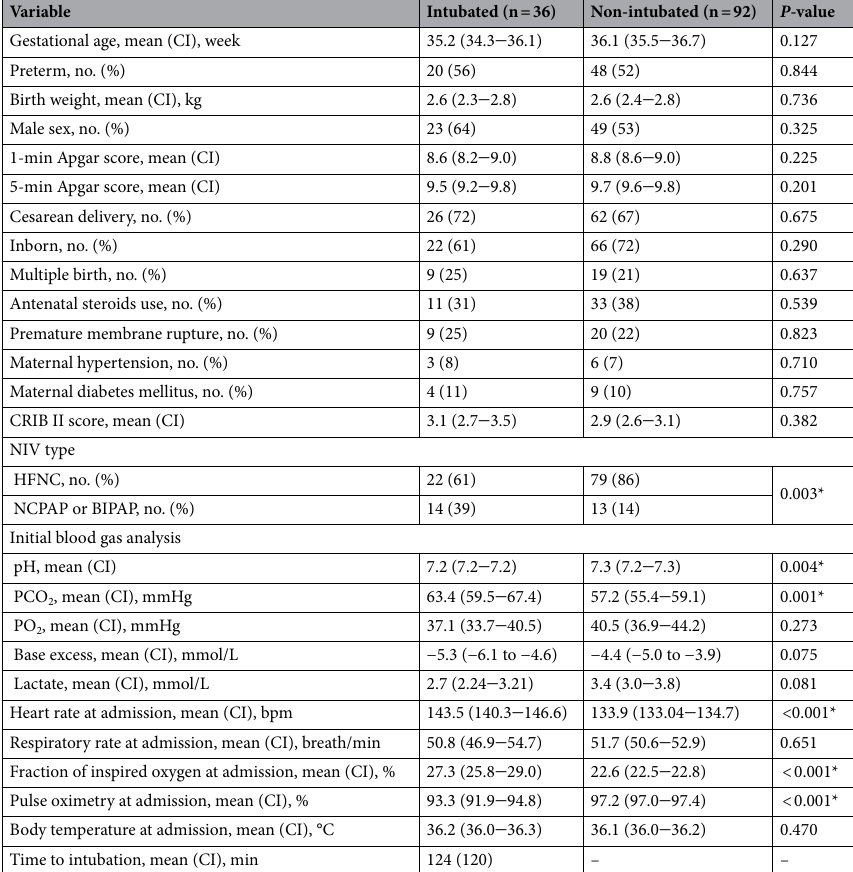
Table 1. Baseline characteristics and outcomes of cohort. CI 95% confidence intervals, HFNC high-flow nasal cannula, NCPAP continuous nasal cannula airway pressure, BIPAP bi-level positive airway pressure. * P -value <